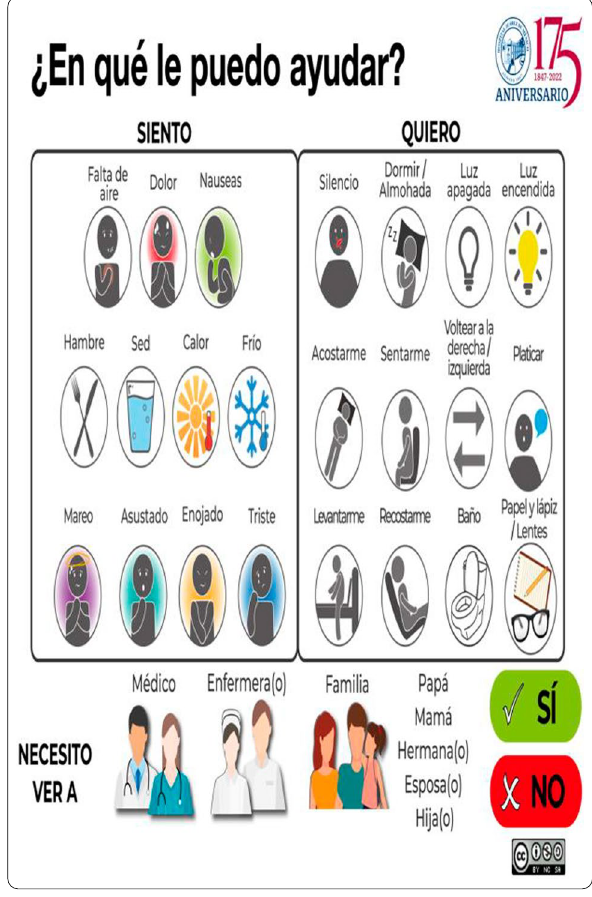
Table 1. Comparison of clinical characteristics and outcome of the 2